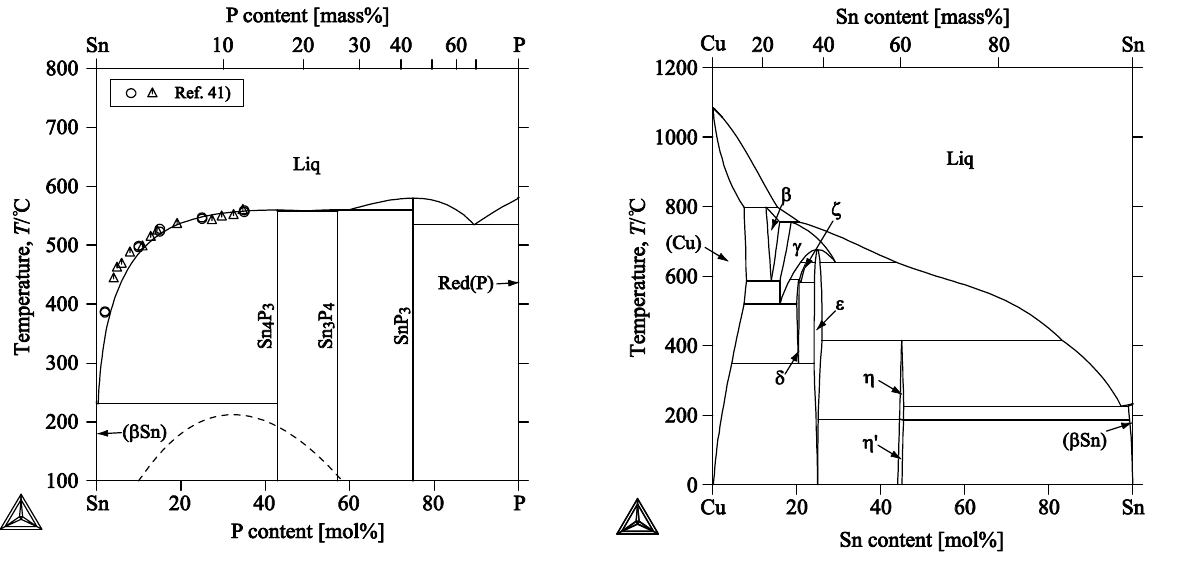
Figure 7. Calculated binary phase diagram of the Cu-Sn